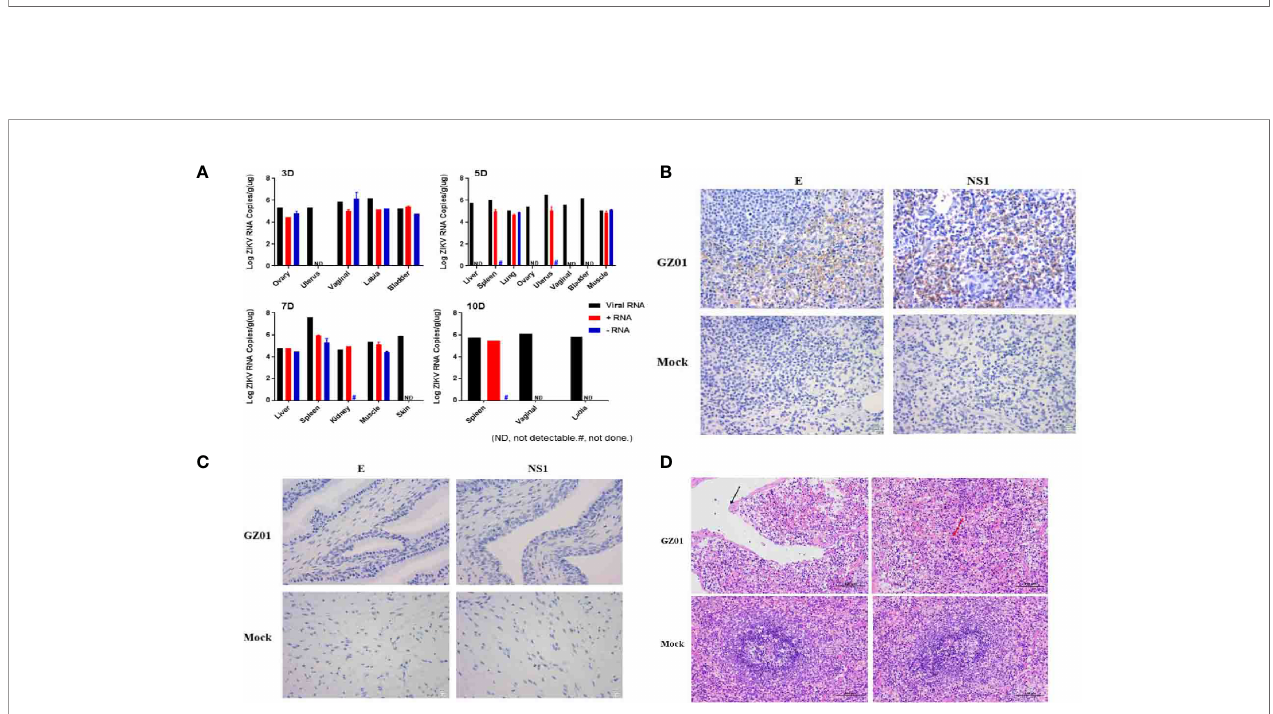
FIGURE 4 | (A) Viral loads in different tissues of ZIKV infected tree shrews were detected by RT-qPCR. (B) IHC detected ZIKV proteins of the spleen of tree shrew 7dpi, Positive viral proteins were shown in brown and DAPI in blue. (C) Histopathological changes in the spleen of tree shrew 7 dpi. The cavities are surrounded by thin connective tissue (black arrows), and macrophages proliferate in the red pulp (red arrows). (D) IHC detected ZIKV proteins of the vagina of tree shrew 3 dpi, Positive viral proteins were shown in brown and DAPI in blue.